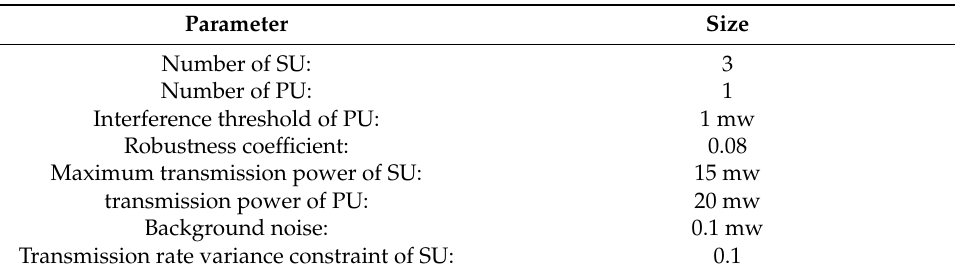
Table 1. Robust model parameter setting.